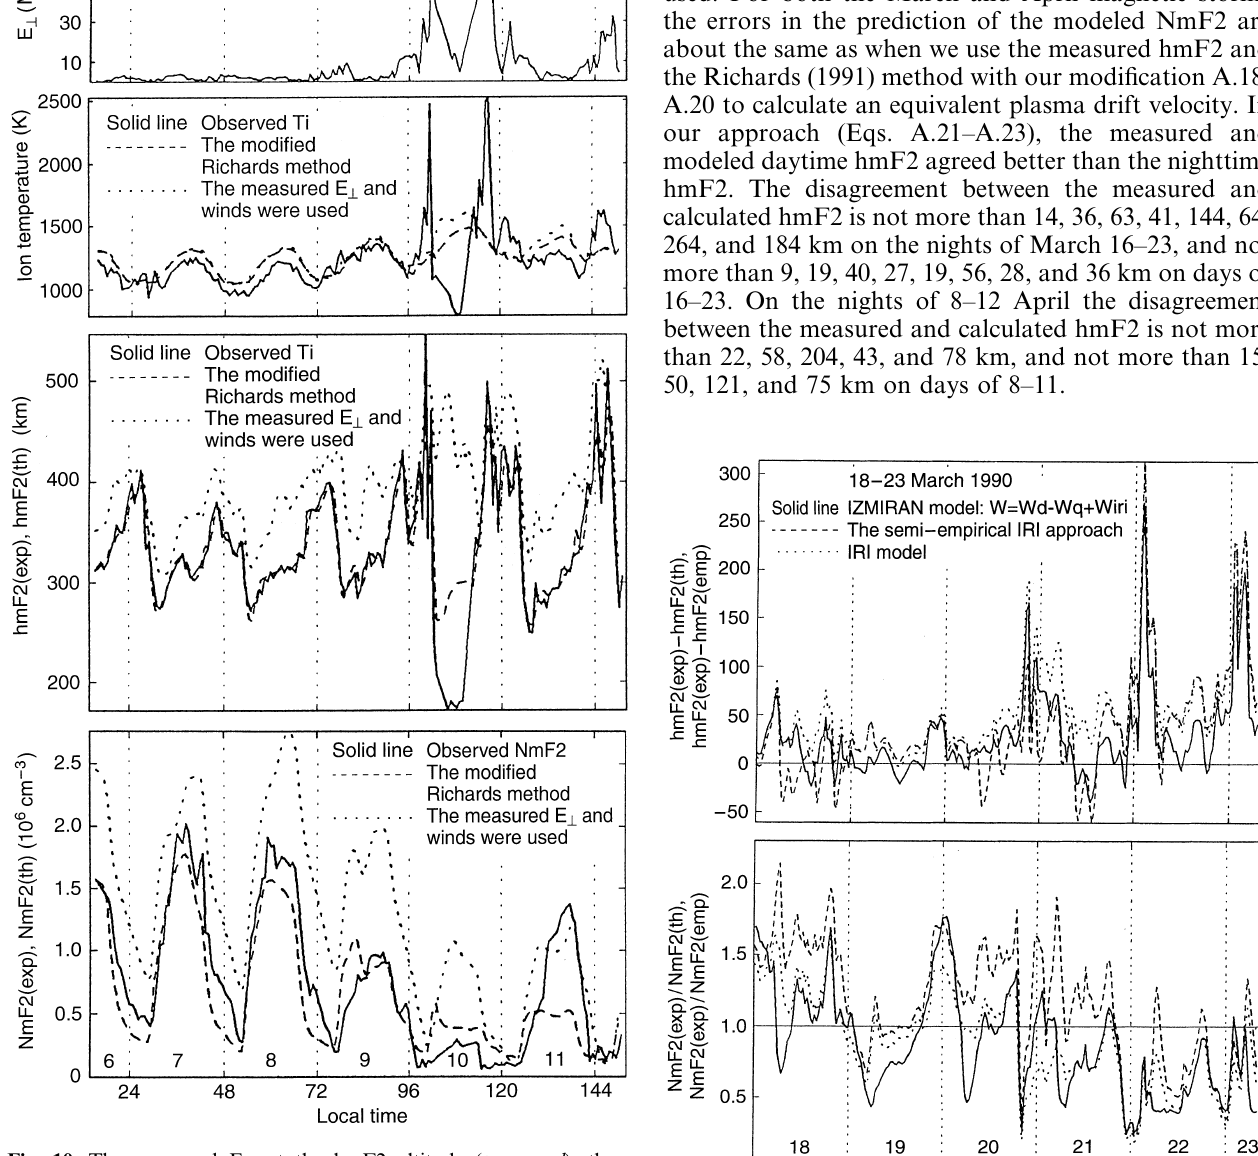
Fig. 10 . The measured E at the hmF2 altitude ( top panel ), the ? measured and modeled T i hmF2 ( two middle panels ), and the measured and modeled NmF2 ( bottom panel ) during the 6–12 April 1990 period for the EUV94X solar flux model. The solid lines are the Millstone Hill data (Buonsanto et al ., 1992a). The dotted lines show Fig. 11 . Comparison of measured NmF2(exp) and hmF2(exp) with the results when we use in the model no E and the approach based peak densities and heights NmF2(th) and hmF2(th) given by the ? IZMIRAN model with algorithm Eq. A.23 ( the solid lines ) and on the method of Richards (1991) for obtaining equivalent neutral NmF2(emp) and hmF2(emp) given by the IRI-90 model ( the dotted winds from the height of the F2 peak electron density, whereas the lines ) and by the semiemprical IRI approach described by Kishcha dashed lines were obtained when the measured E and meridional ? neutral winds were used. All the model results have been obtained (1995) ( the dashed lines ) for the disturbed period of 18–23 March 1990. The Boltzmann vibrational distribution of N 2 ( v ), and the from the IZMIRAN model with the Boltzmann populations of the first five vibrational levels of N 2 ( v ), the O (cid:135) (cid:255) O frequencies given by original recombination rate of O (cid:135) (cid:133) 4 S (cid:134) ions are implied in the Salah (1993), and the original recombination rate of O (cid:135) (cid:133) 4 S (cid:134) ions IZMIRAN